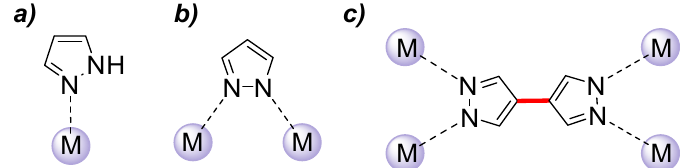
Figure 2. The pyrazole functional group can coordinate with a single metal ion ( a ) or can bridge two metal ions as a deprotonated pyrazolate ( b ). The 4,4’-bipyrazolate ligand can coordinate up to four different metal ions ( c ).